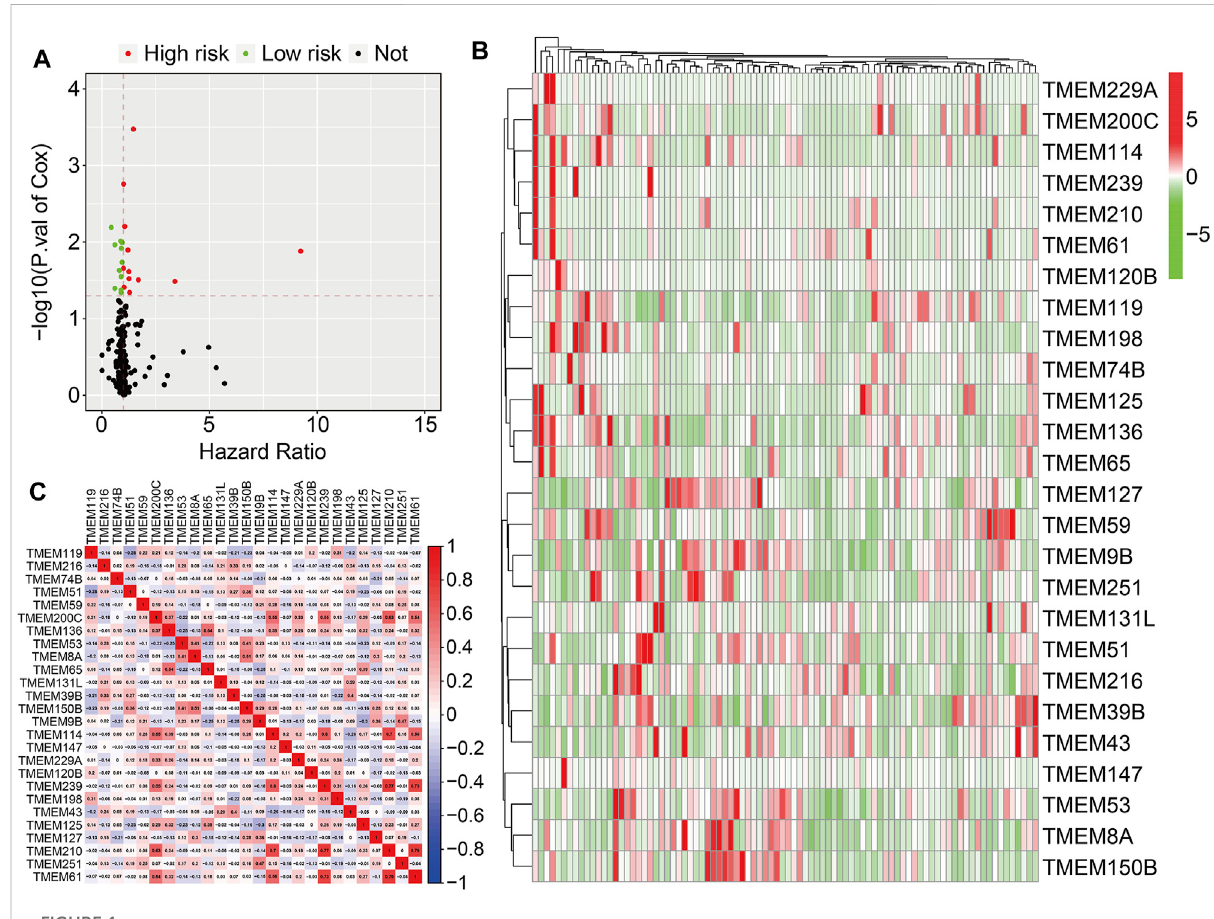
FIGURE 1 Identi fi cation of prognosis-related transmembrane (TMEM) protein family genes in osteosarcoma. (A) Prognosis-related TMEM protein family geneswereidenti fi edbyperformingaunivariateCoxregressionanalysis. (B) Expressionpro fi lesoftheprognosis-relatedTMEMproteinfamilygenes. (C) Correlation of the TMEM protein family genes based on the gene